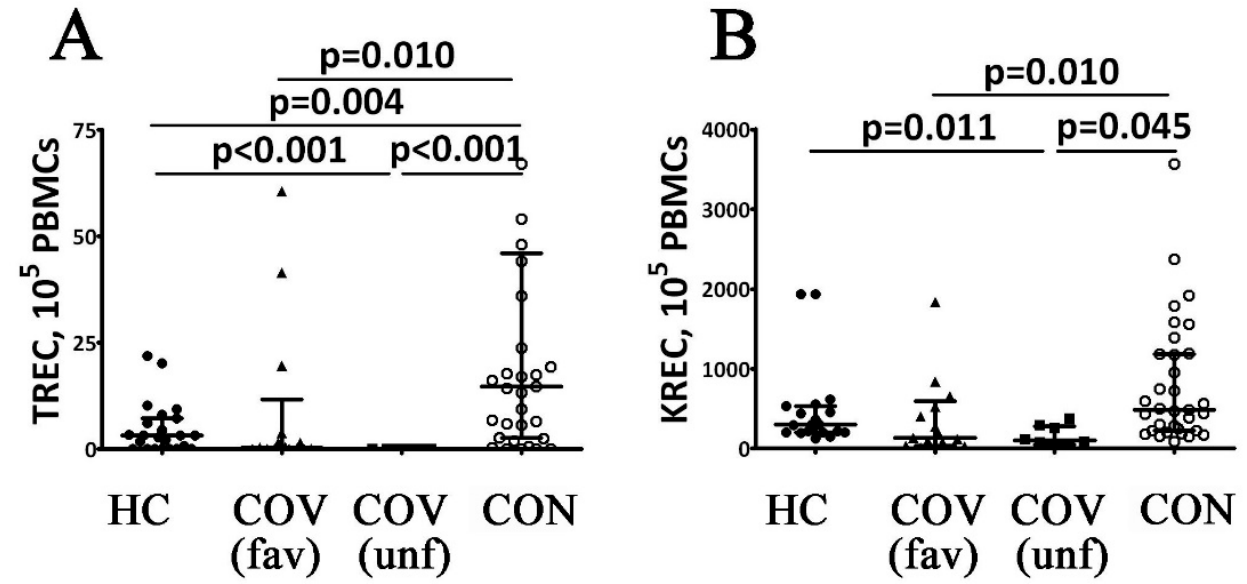
Figure 1. T cell receptor excision circles (TREC) and Kappa-deleting recombination excision circles (KREC) counts in patients with acute COVID-19 and COVID-19 convalescent patients. Scatters plots ( A , B ) showing the numbers (copies per 105 cells) of TRECs and KRECs, respectively Black circles—healthy control (HC, n = 24); black triangles—patients with acute COVID-19 (COV (fav), favorable outcome, n = 25); black squares—patients with acute COVID-19 (COV (unf), unfavorable outcome, n = 8); and white circles—COVID-19 survivors (CON, convalescent patients with favorable outcome of acute COVID-19, n = 33). Each dot represents individual subjects, and horizontal bars depict the group medians and quartile ranges (Med (Q25; Q75). Statistical analysis was performed with the Mann–Whitney U